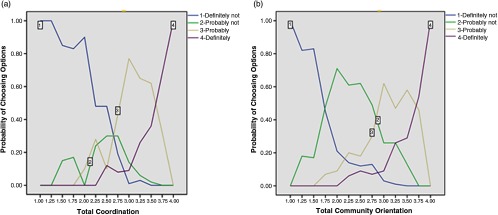
Response graph by non-parametric item response theory analysis contrasting poorly and well-performing items. (a) Option characteristic curves for item CD4 in coordination ‘Was your primary care provider interested in the quality of care there?’ are modeled as a function of total scores on these measures (bottom axis). Results show difficulties with some options from this item. The probability of endorsing option 2 is relatively small compared to other options. (b) Option characteristic curves for item C01 in community orientation ‘Does your primary care provider do survey in the community to find out about health problems he or she should know about?’ are modeled as a function of total scores on these measures (bottom axis). Results show that this item performs well relative to other items.